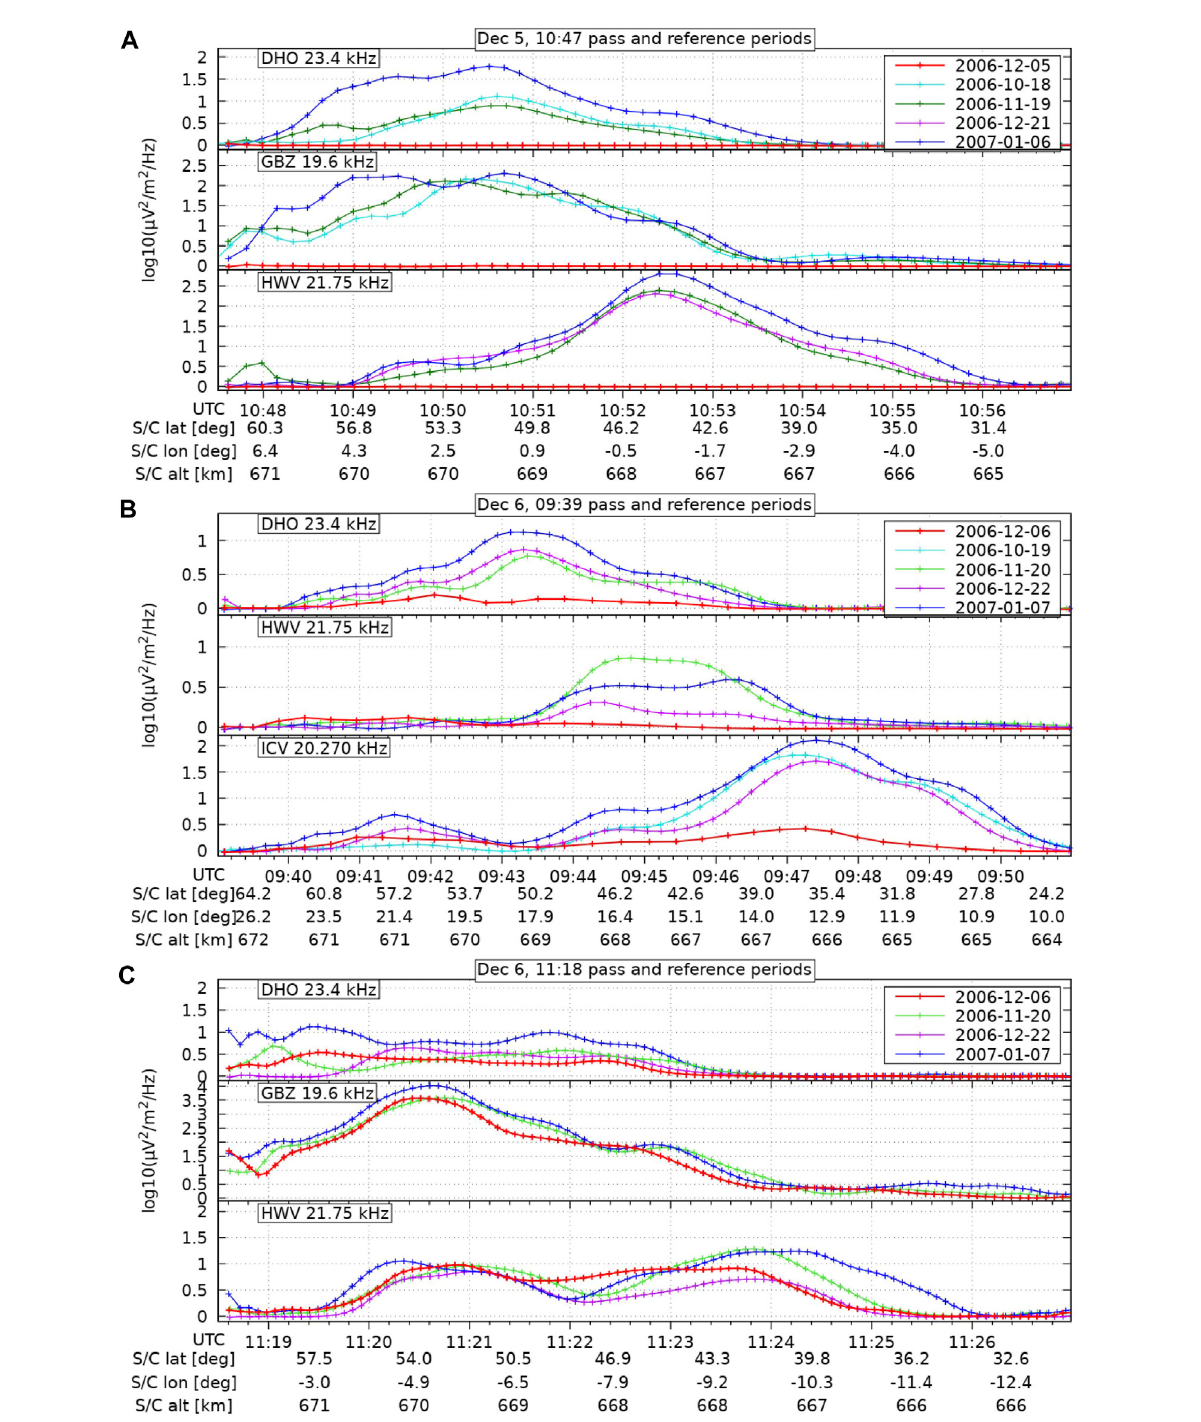
FIGURE 9 Transmitter signal power measured on the DEMETER satellite, during three passes (red curves) and during corresponding reference periods. After the class X9 fl are event (05 December 2006, (A) , complete VLF fade-out can be observed (signal falls to background level). About 70 min after the class M fl are event (B) , signi fi cant VLF attenuation can be observed. Another 100 min later, no clear difference compared to reference days (C)